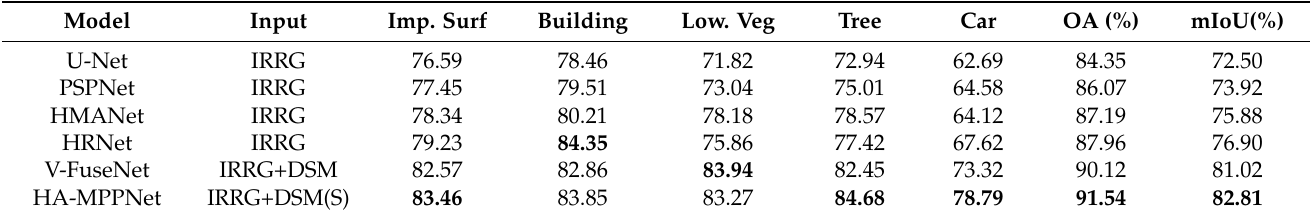
Table 1. Comparisons with state-of-the-art methods on the Vaihingen dataset. The accuracy of each category is presented in the IoU form. DSM(s) is the model using the DSM image as additional supervision.